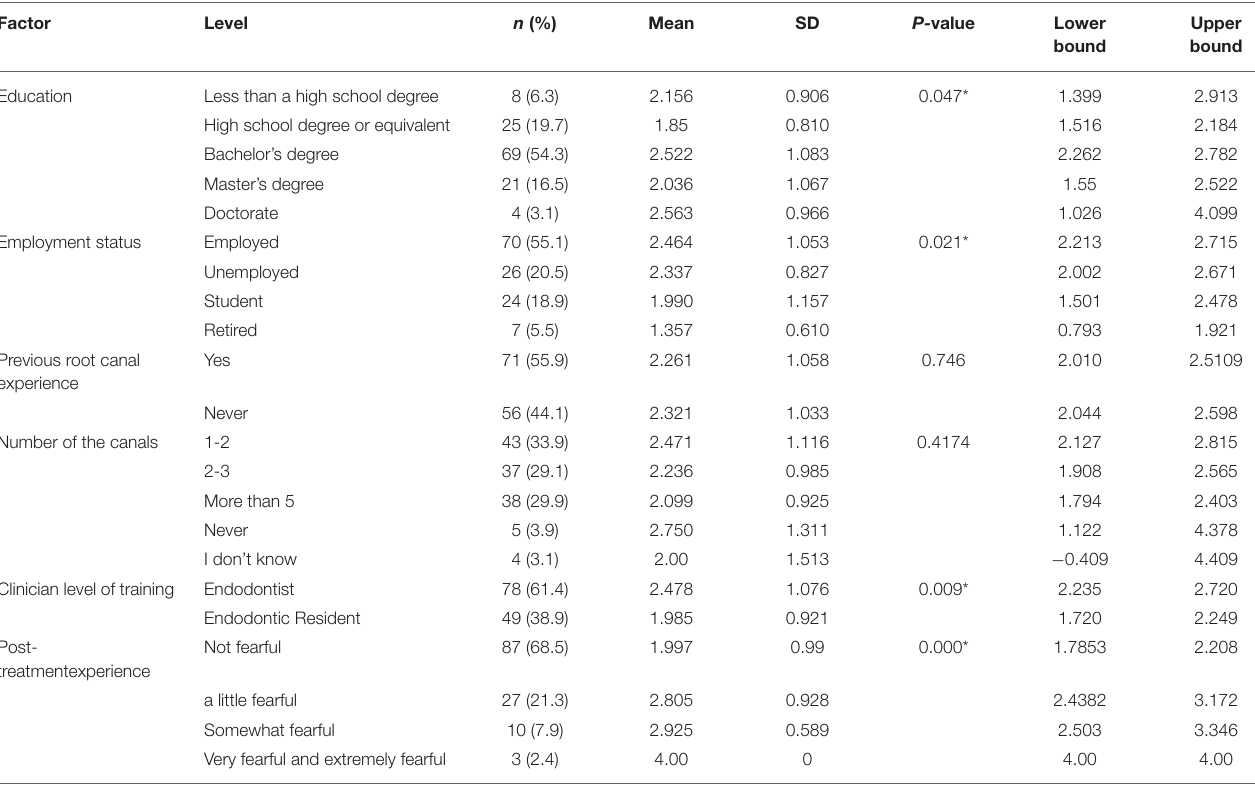
TABLE 3 | Mean MDAS scores and SD related to education and employment status, number of root canal treatments received, clinician level of training, previous root canal treatment, and post-treatment